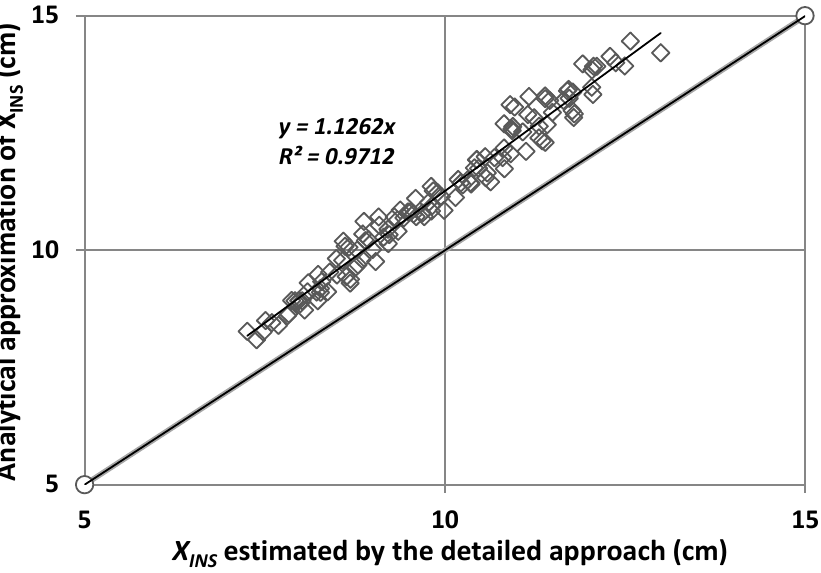
Figure 12. Optimum thermal transmittance values estimated in the sensitivity analysis, as compared to the respective values by applying the analytical expression.